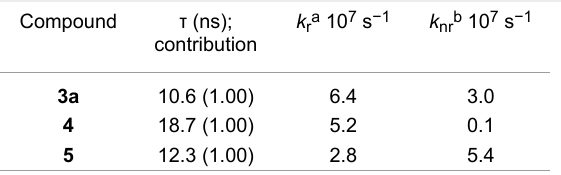
Table 2: Fluorescence lifetimes and decay rate constants for 3a and 5 in CHCl 3 and for 4 in 0.01 M PBS (pH 7.35). Compound